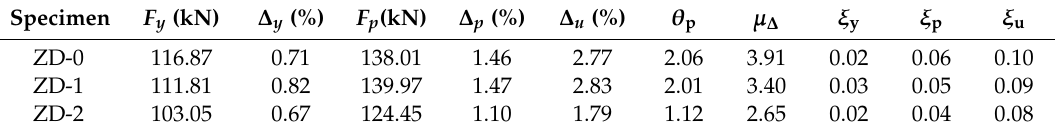
Figure 9. Envelops of the hysteresis loops. Table 3. Force and deformation of the tested columns (units: % and kN).